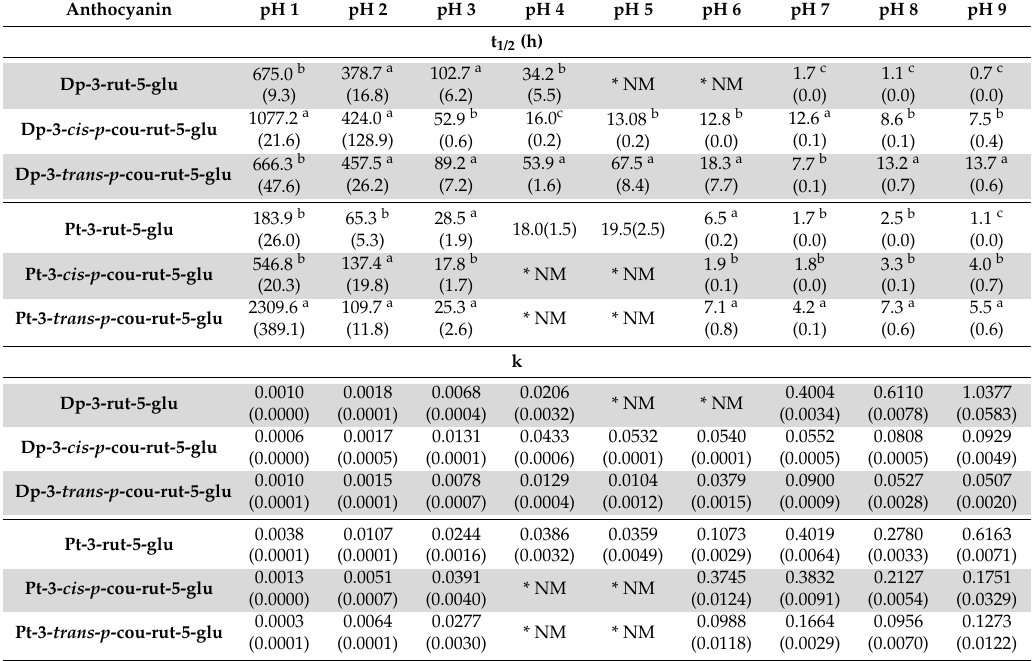
Table 3. Half-lives (h) and rate constants (k) of delphinidin (Dp) and petunidin (Pt) derivatives in pH 1–9, n = 3. Different superscript letters indicate significant differences ( p < 0.05) between derivatives of the same anthocyanidin in the same